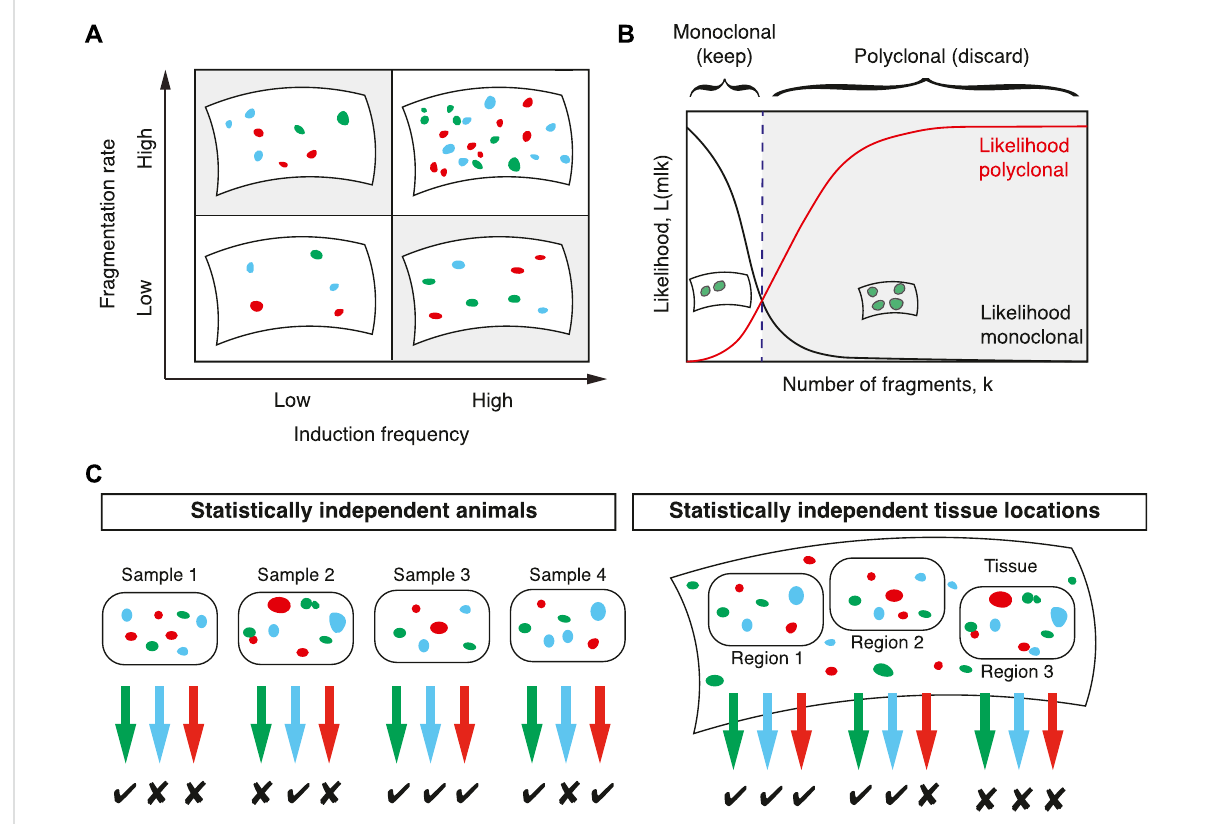
FIGURE 3 Computing clonal fragmentation rates. (A) The number of labelled cell clusters depends in similar ways on the induction frequency and the fragmentationrate(shadedareas).Sincebothare apriori unknowntheirsimultaneousinferenceischallenging. (B) Todeterminewhetherasampleis monoclonal,astatisticalframeworkbasedoncomparingthelikelihoodthatasampleismonoclonal(blackline)withthelikelihoodthatitispolyclonal (redline)de fi nesathreshold(dashedline)inthenumberoffragmentsthatseparatessamplesthatareconsideredmonoclonalorpolyclonal. (C) For each sample colors with more fragments than the threshold value de fi ned in (B) are discarded. Samples can be tissues from different animals or large,butspatiallyseparatedandstatisticallyindependenttissueregionsfromthesameanimal.Inthisexample,sampleswithtwoorfewerfragments are considered